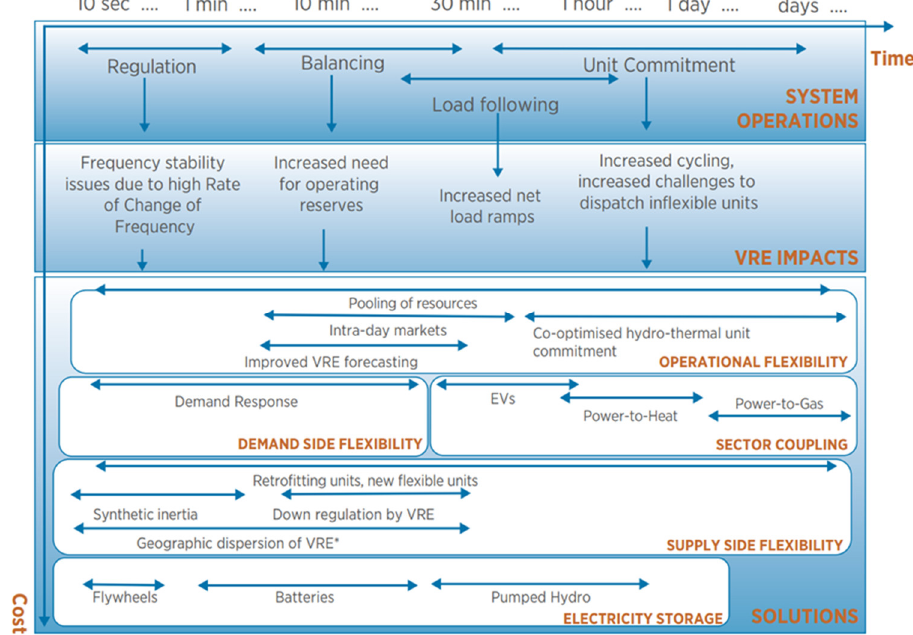
Figure 5. Flexibility solutions relevant to intermittent renewable production [52].